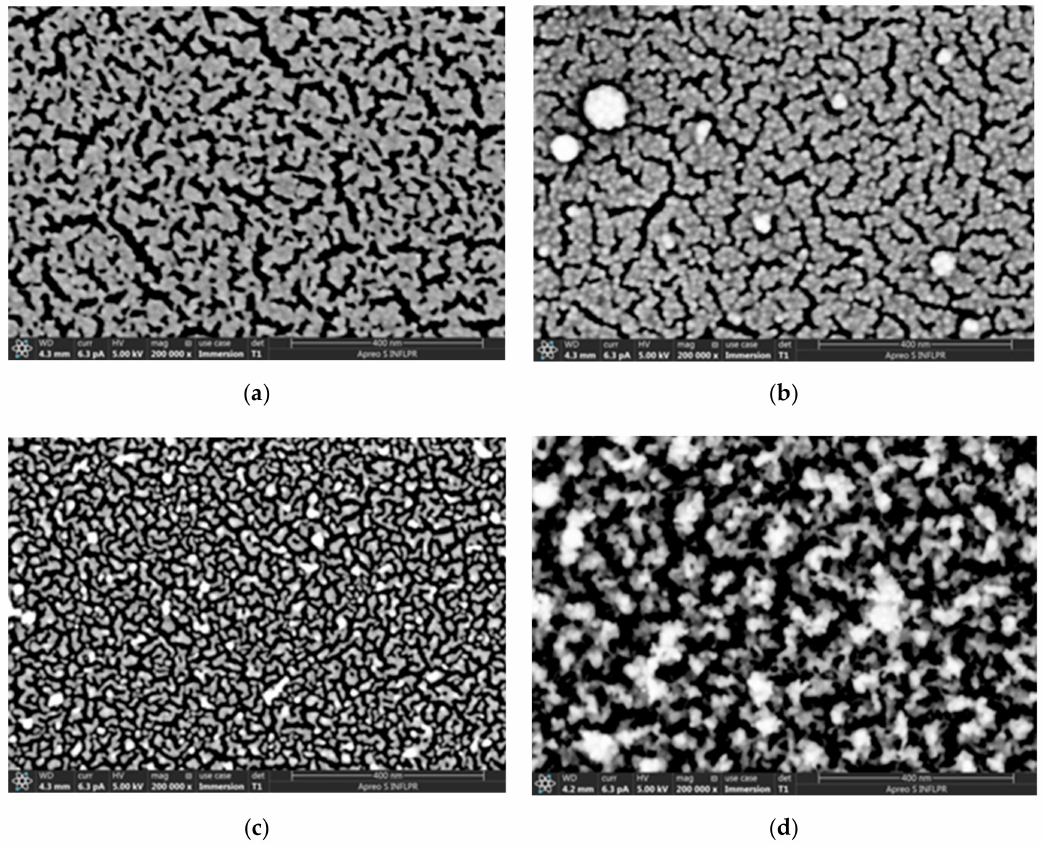
Figure 2. SEM images of the gold layers deposited directly onto Si substrates for high Ar deposition pressures and various numbers of ablation pulses. ( a ) 1 Torr, 9800 pulses; ( b ) 1 Torr, 30,000 pulses; ( c ) 4 Torr, 9800 pulses (same as Au layer in S2); ( d ) 4 Torr, 30,000 pulses (same as Au layer in S3). Scale bars are 400 nm in all